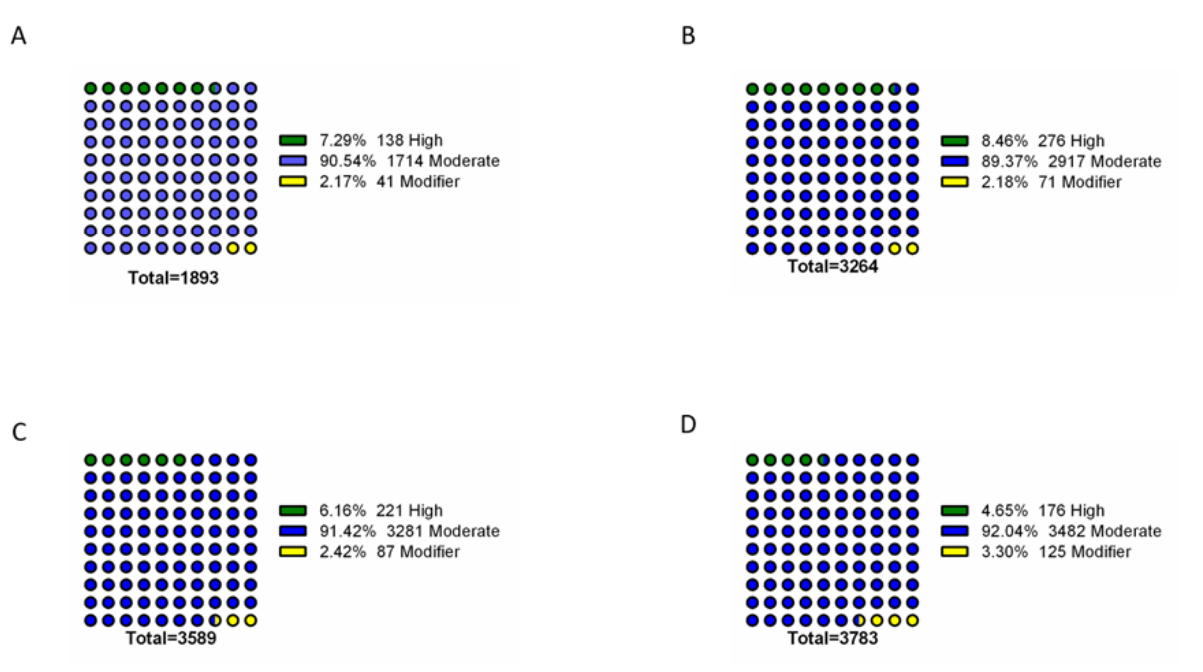
FIGURE 2: Impact analysis of genomic variants found exclusively in the genomes of resistant isolates. The assessed mutations are present in the genomes of azole resistant (A) , echinocandin intermediate (B) , echinocandin resistant (C) and multi resistant (D) isolates, being ab- sent from the genomes of susceptible isolates. For each resistance group, the catalogued mutations are specific to that group. Variant im- pact was predicted with SnpEff [10]: High – the variant is assumed to have high (disruptive) impact in the protein, probably causing protein truncation, loss of function or triggering nonsense mediated decay; Moderate - A non-disruptive variant that might change protein effec- tiveness; Modifier – usually non-coding variants or variants affecting non-coding genes, where predictions are difficult or there is no evi- dence of